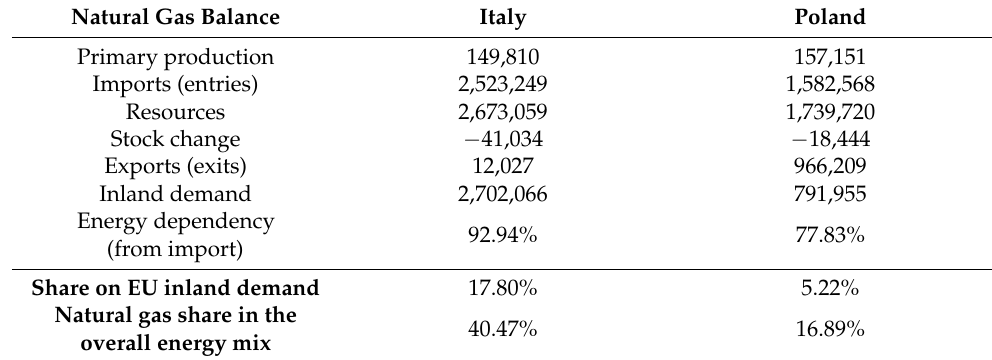
Table 3. Natural gas balance in Italy and Poland in 2020. Values are expressed in terajoules (gross calorific value).